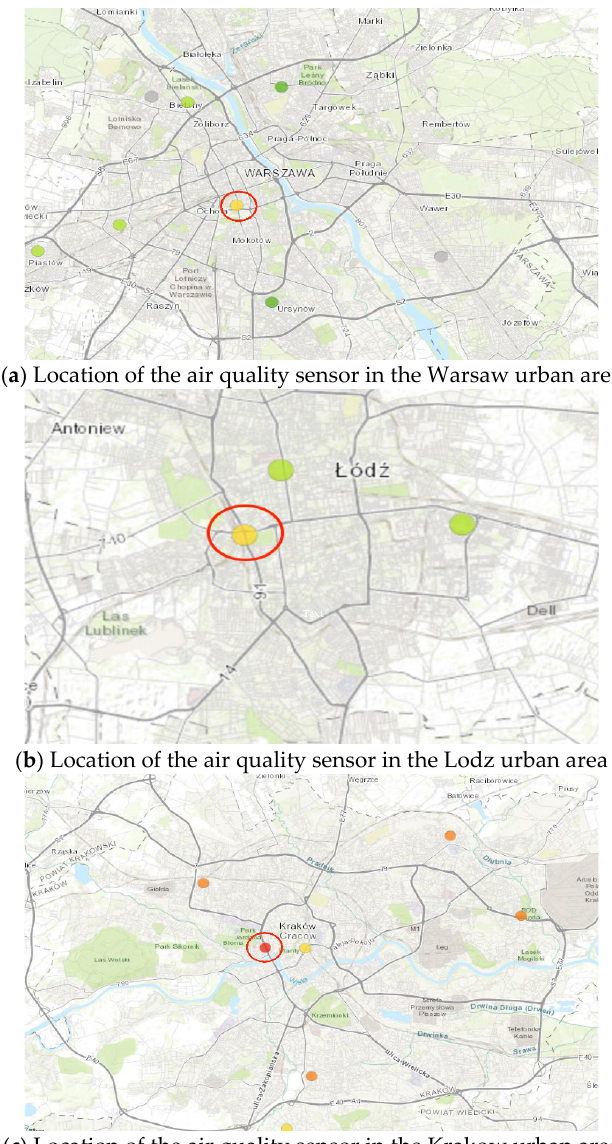
Figure A1. Location of the air quality sensors in Poland’s three main urban areas: ( a ) Warsaw, ( b ) Lodz, and ( c ) Krakow. Source: Snapshot from Poland’s Chief Inspectorate For Environmental Protection (http://powietrze.gios.gov.pl/pjp/home (accessed on 9 March 2022)). Green color: good air quality (low level of pollutants). Yellow color: medium air quality (medium level of pollutants. Orange color: low air quality (high level of pollutants). Red color: very low air quality (very high level of pollutants).